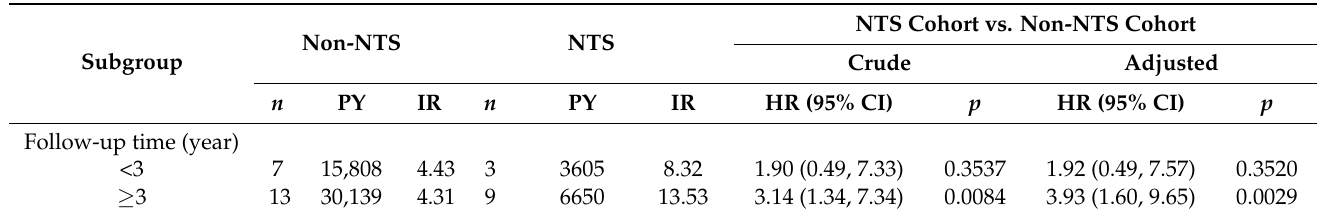
Table 4. Incidence rate and hazard ratio of hematological malignancy in patients older than 60 with different follow-up times in Taiwan in